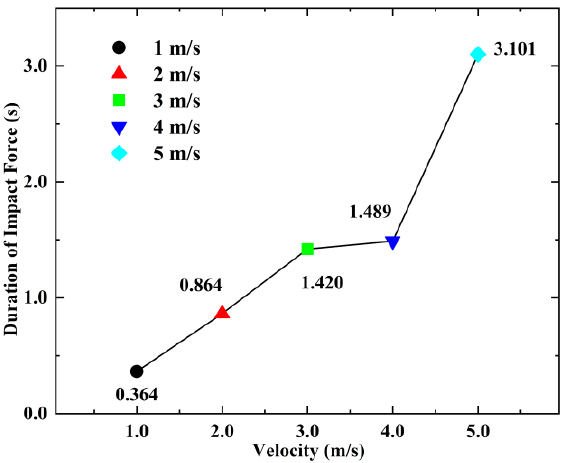
Figure 12. Collision durations at different impact velocities.